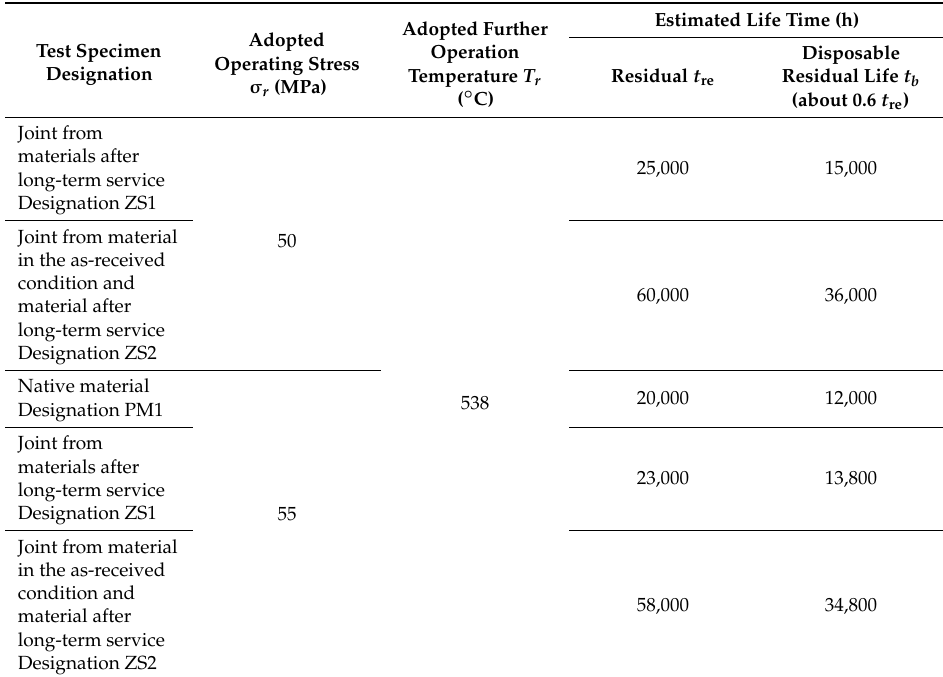
Table 6. Residual life determined and disposable residual life estimated by abridged creep tests of the parent material, repair welded joint made from materials after long-term service and repair welded joint made from material in the as-received condition and after long-term